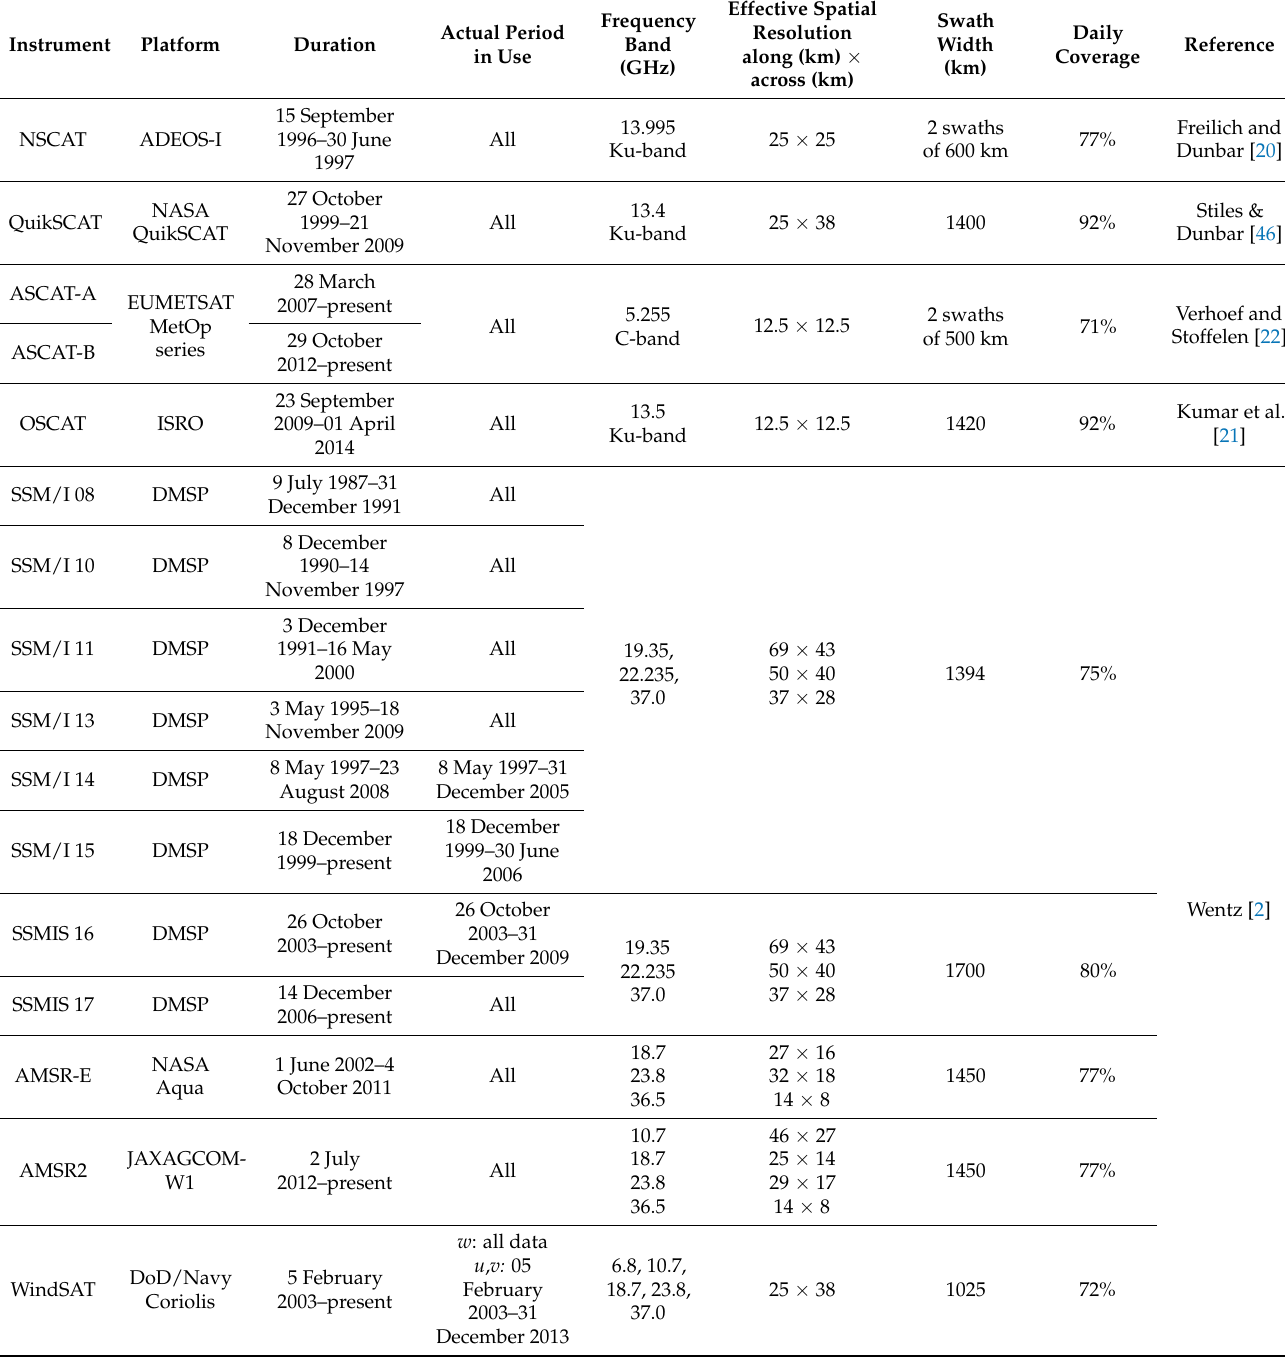
Table 1. Characteristics of the 16 sensors included in the OAFlux-HR vector wind